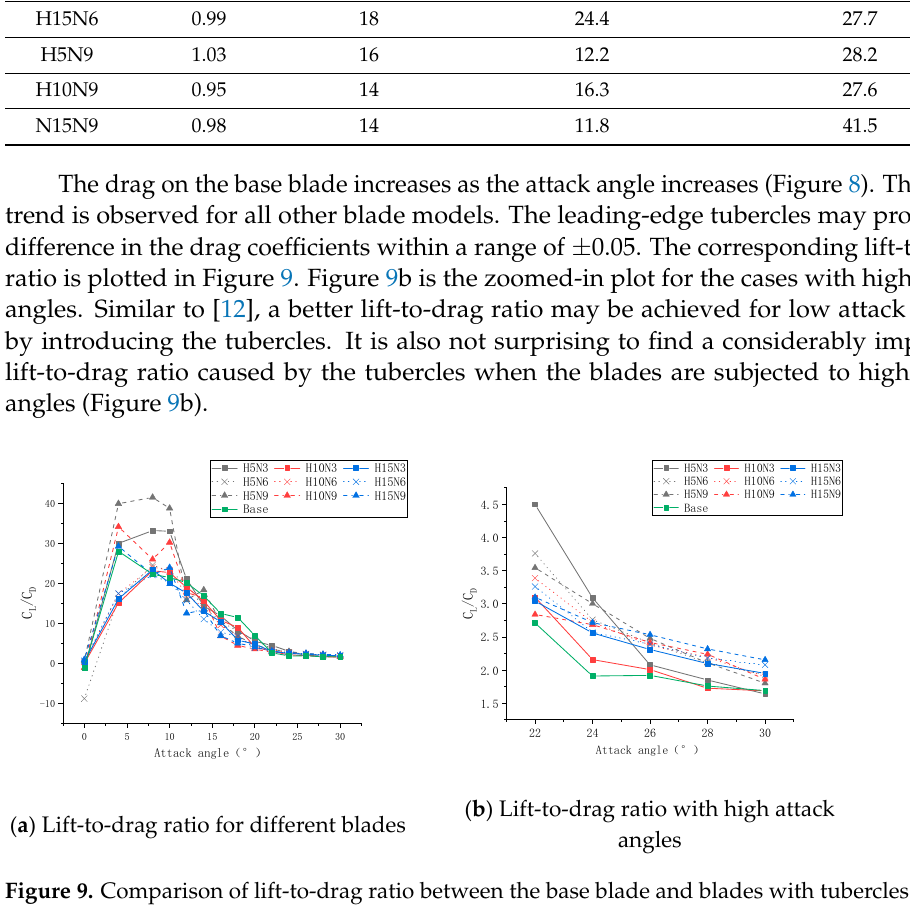
Figure 9. Comparison of lift-to-drag ratio between the base blade and blades with tubercles. As indicated in the Introduction, the vortex structure and flow separation play critical roles on the hydrodynamic performance of the blade. To further examine such small-scale phenomenon, the iso-surface of the Q-criteria, which is defined as where Ω and S are the vorticity tensor and the rate of strain tensor, respectively, and the distribution of the streamline near the blades are illustrated. Figure 10 plots the corresponding values for the base blade with attack angles smaller than the stall point (18°). It is clear that the flow is attached to the majority of the base blade surface, although the flow separation begins to initiate at the lower section of the blade close to the smallest chord when the attack angle is 14° (Figure 10a,b) and becomes more significant as the attack angle increases to 16°. Such a change in the flow characteristics may explain the change in the gradient of the lift of the base blade between 14° and 16° and 16° and 18° in Figure 7.